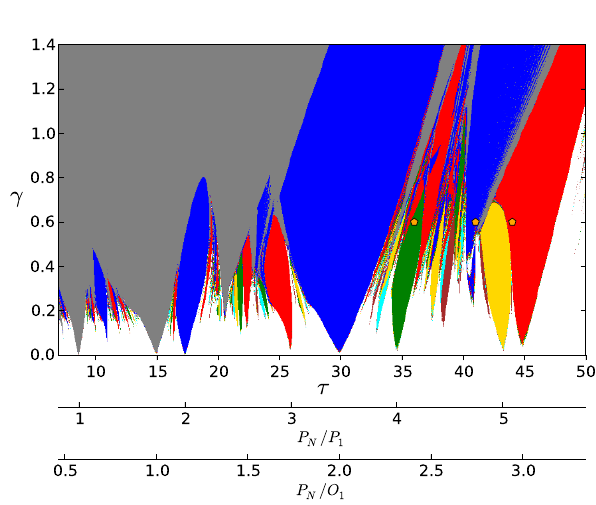
Fig. 7. Pullback (at t 0 = 0) and stroboscopic sections ( t = 0 + nP 1 and t = 0 + nO 1 ) obtained with the van der Pol oscillator with pa- rameters α = 30, β = 0 . 7, and forced by F(t) = γ( sin ( 2 πt/P 1 + φ P 1 ) + sin ( 2 πt/O 1 ) + φ O 1 ) , P 1 = 23 . 7ka and O 1 = 41 . 0ka and γ = 0 . 6, and three different values of τ . The presence of dots on the pullback section indicates generalised synchronisation. Localised closed curves on the stroboscopic sections indicate frequency lock- ing on the corresponding period (on P 1 with τ = 36ka and O 1 with τ = 44ka), and complex geometries indicate the presence of a strange attractor ( τ = 41ka).